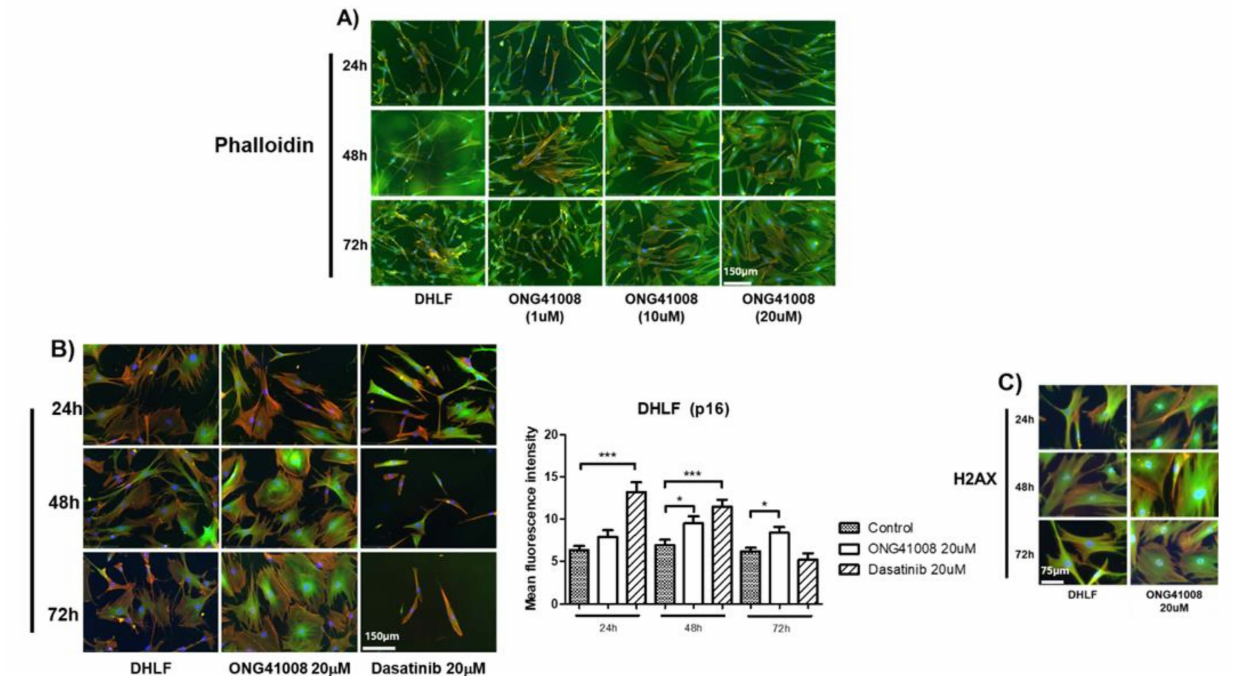
Figure 3. Induction of replicative senescence by ONG41008 and an interactome analysis. ( A ) DHLFs were treated with different concentrations of ONG41008 or a control (RPMI medium). Immunocy- tochemistry (ICC) was conducted with antihuman GATA6, phalloidin, and DAPI. Morphological changes were monitored under phase-contrast and fluorescence microscopy. Images that show typical replicative senescent cells are denoted by the phrase “replicative senescence”. ( B ) DHLFs were stimulated with 20 µ M ONG41008 or 20 µ M dasatinib for 24, 48, or 72 h, and replicative senescence was compared via ICC with the use of anti-p16. ( C ) DHLFs were stimulated for 24, 48, or 72 h and stained with anti-H2AX. ICC images were